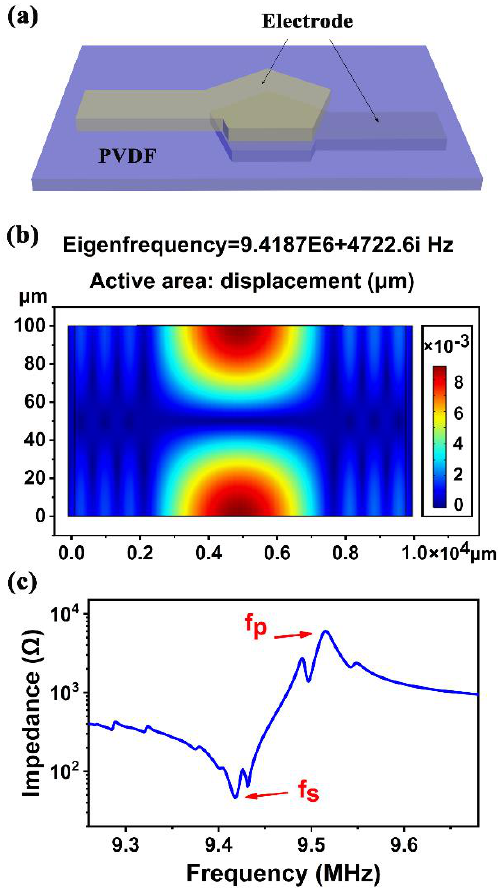
Figure 2. ( a ) Three-dimensional schematic of FBAR device structure; ( b ) simulated 2D cross-section displacement of β -phase PVDF FBAR in COMSOL; and ( c ) impedance of β -phase PVDF FBAR in COMSOL.